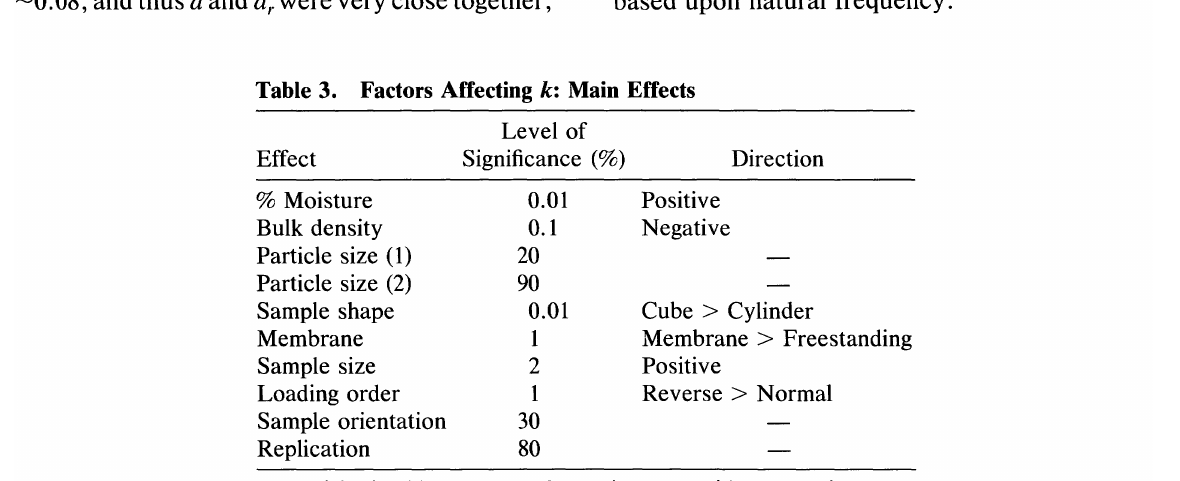
Table 3. Factors Affecting k: Main